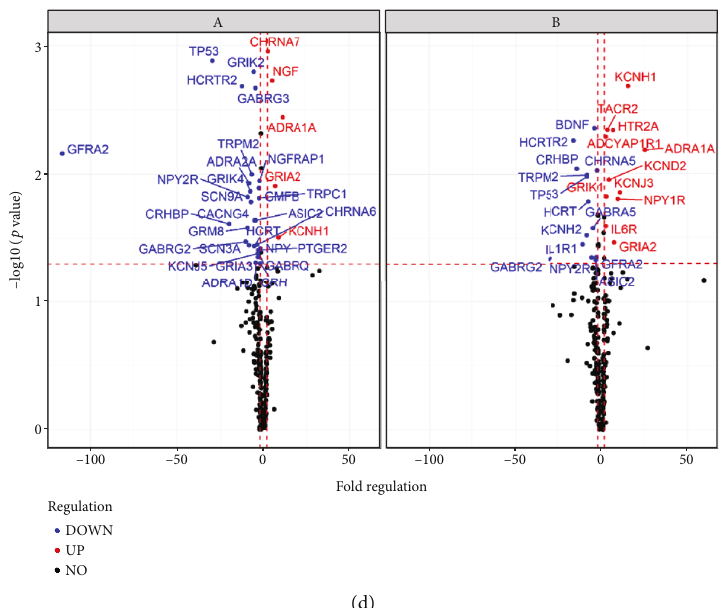
Figure 3: Neuronal gene expression pattern of cells of approach A and B. Genes involved in motor neurogenesis (a, c) and genes associated with the expression of neuronal ion channels, neurotransmitters, and neurotrophins (b, d) were di ff erently expressed in approaches A and B compared to NPC, tested by qRT-PCR. Results are shown in a heat map (a, b), where red indicates signi fi cant downregulation while green represents signi fi cant upregulation of genes, and in a volcano plot (c, d), where a p value of 0.05 is indicated by a horizontal red dashed line and a fold regulation of -2.0 and 2.0 is represented by vertical red dashed lines ( n = three independent